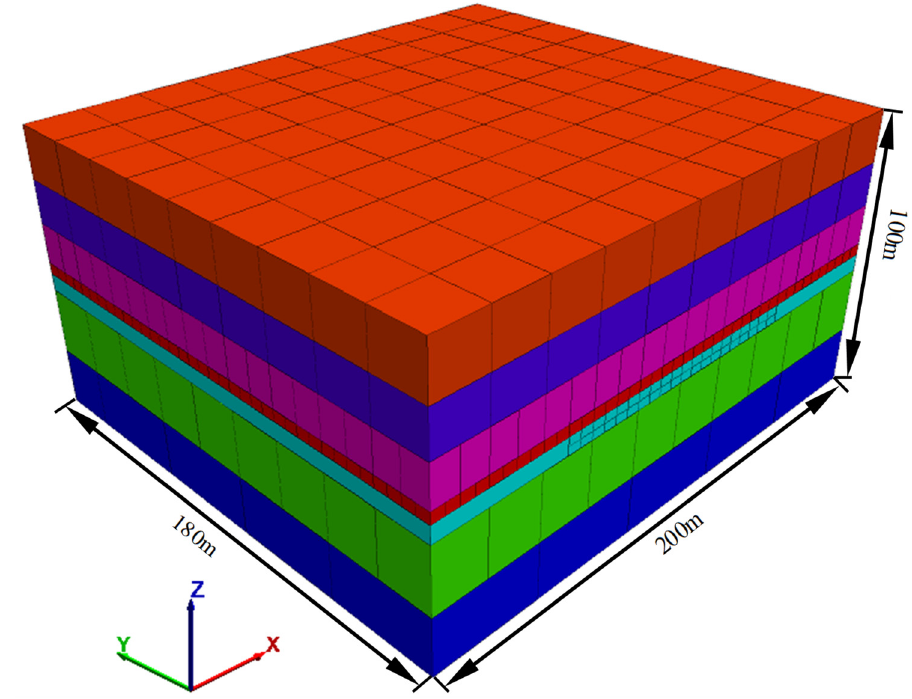
Figure 5. 3DEC numerical simulation model. Table 4. Mechanical parameters of coal seam joint surface.